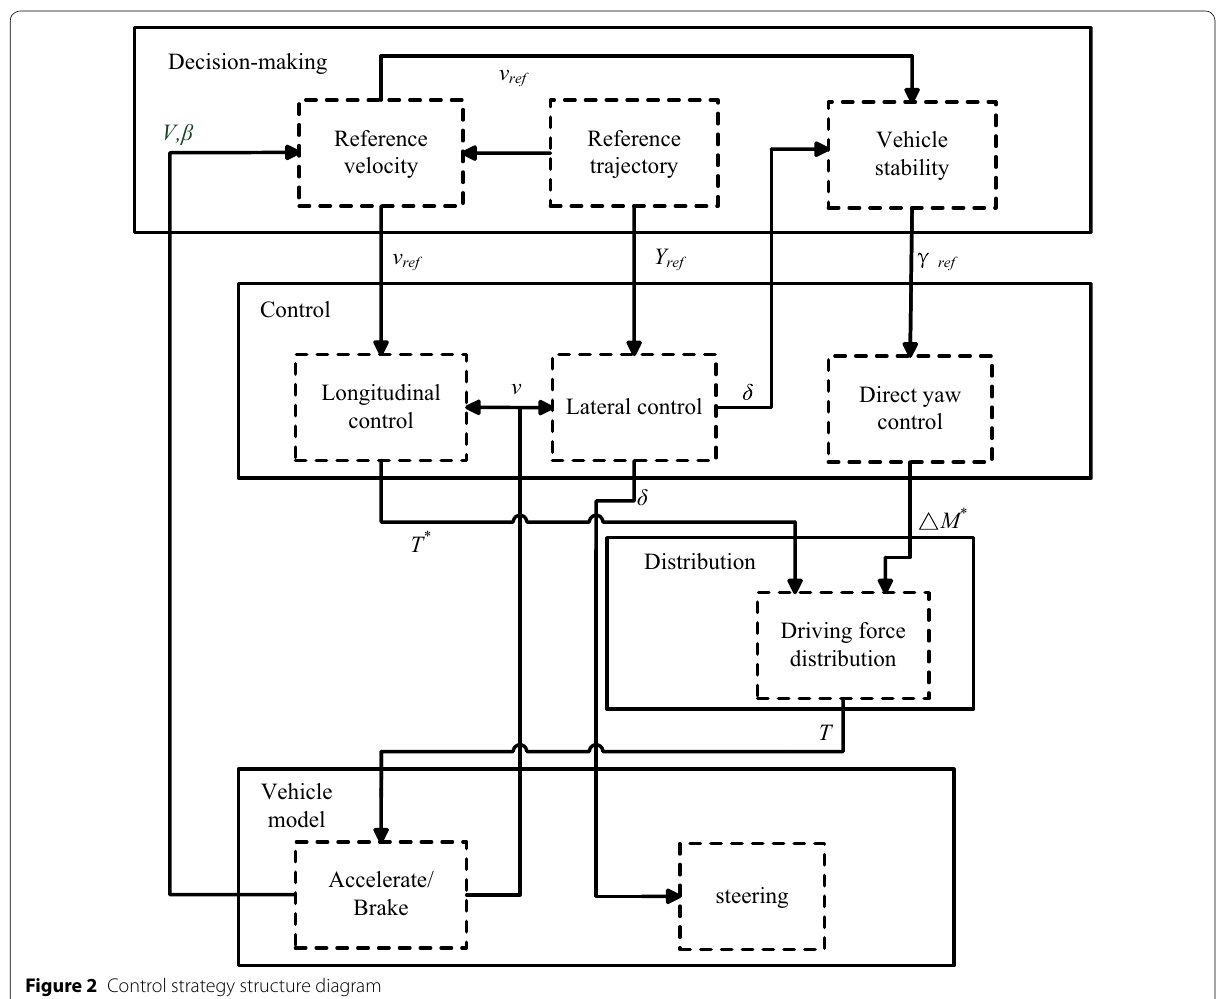
Figure 2 Control strategy structure